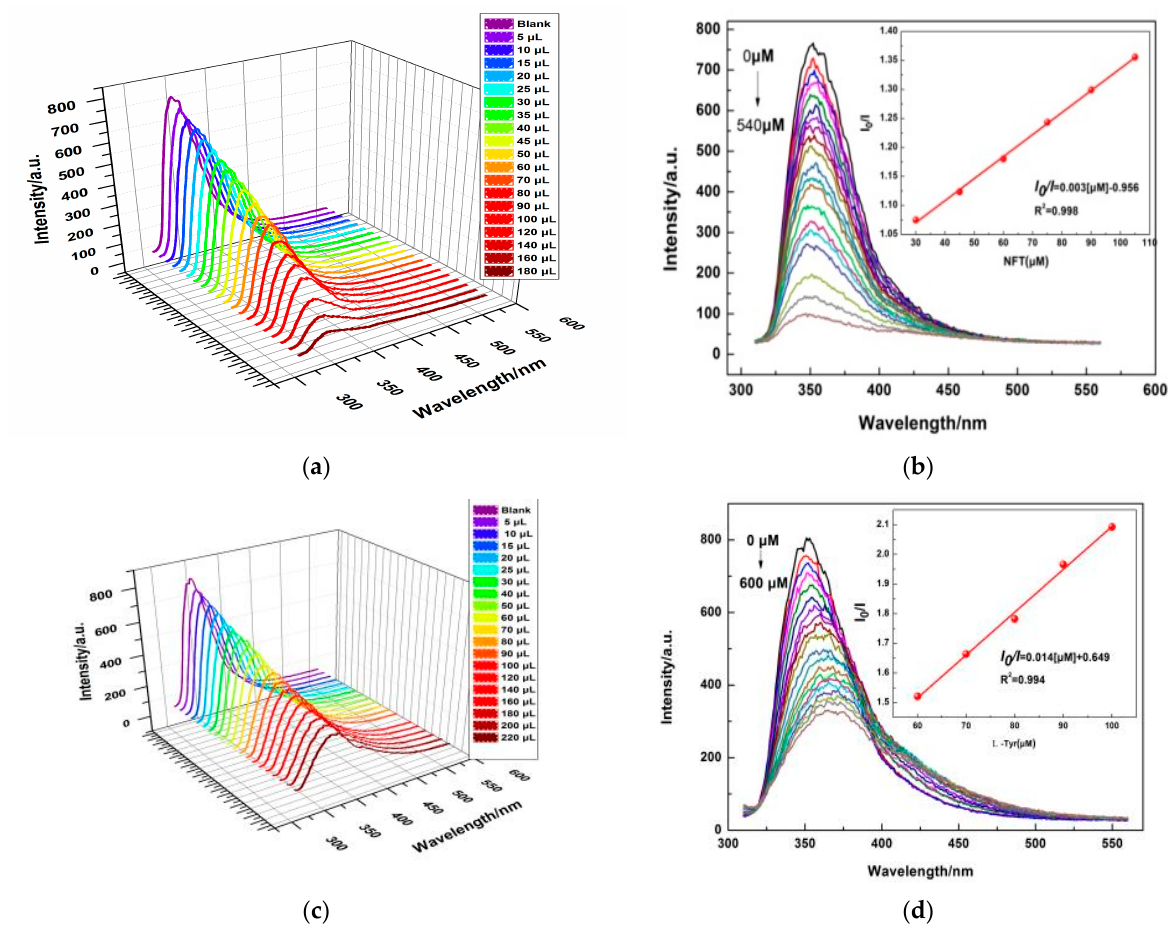
Figure 5. ( a ) The luminescence spectra of 1 with different concentrations of NFT; ( b ) The emission spectra by adding different concentration NFT buffer excited at 300 nm; ( c ) The luminescence spectra of 1 under different concentrations of L -Tyr; ( d ) The emission spectra by adding different concentration L -Tyr buffer excited at 300 nm.